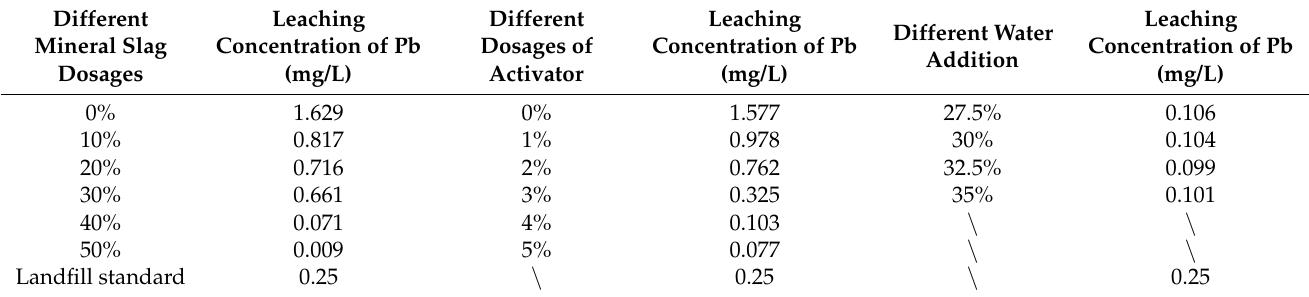
Table 5. Leaching of Pb from solidified bodies under different